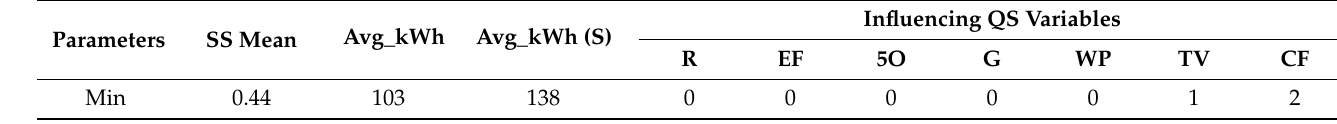
Table 9. 2nd-stage SOM + KM with clustering analysis of C1. Table 8. 1st-stage indirect KM clustering analysis of